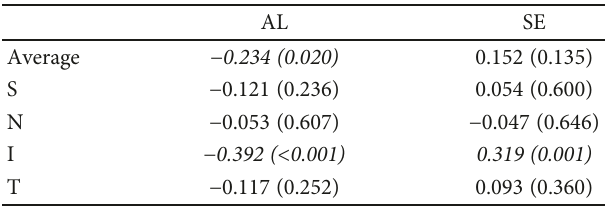
Table 3: Correlation between overall and regional peripapillary vessel density and myopic